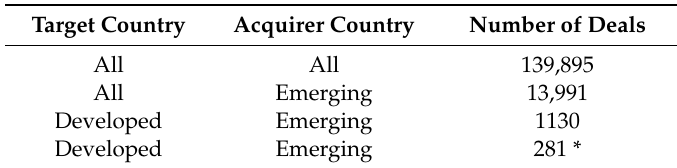
Table 1. Full sample overview.